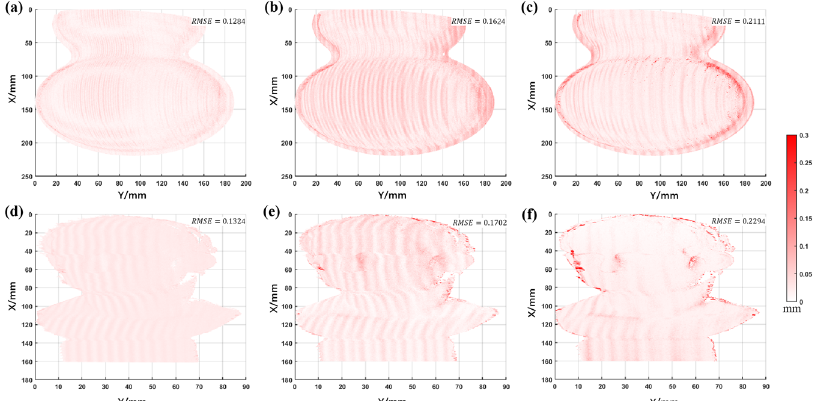
Figure 16. The ED maps between the three methods and the ground truth (the first and the second rows refer to the measured gourd and statue, respectively). ( a , d ) The ED map of the proposed method. ( b , e ) The ED map of the traditional TFH method. ( c , f ) The ED map of the DFH method (the RMSE of each method is marked).